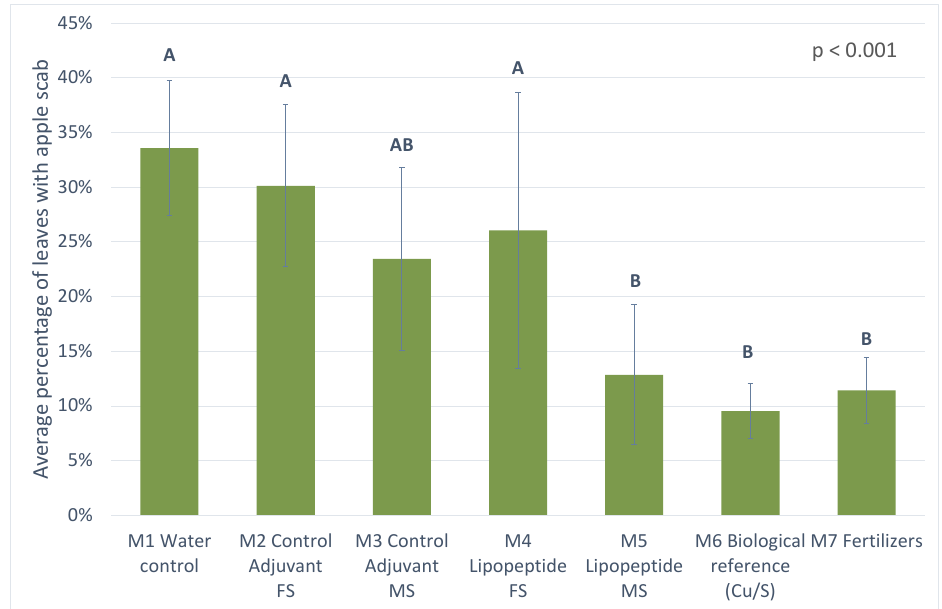
Figure 7. Graphical representation of the levels of leaf scab contamination in the different modalities following the 2019 trials at the end of primary contamination. The different statistical groups are represented by the letters A and B. A rating of AB indicates that this modality belongs statistically to groups A and B.